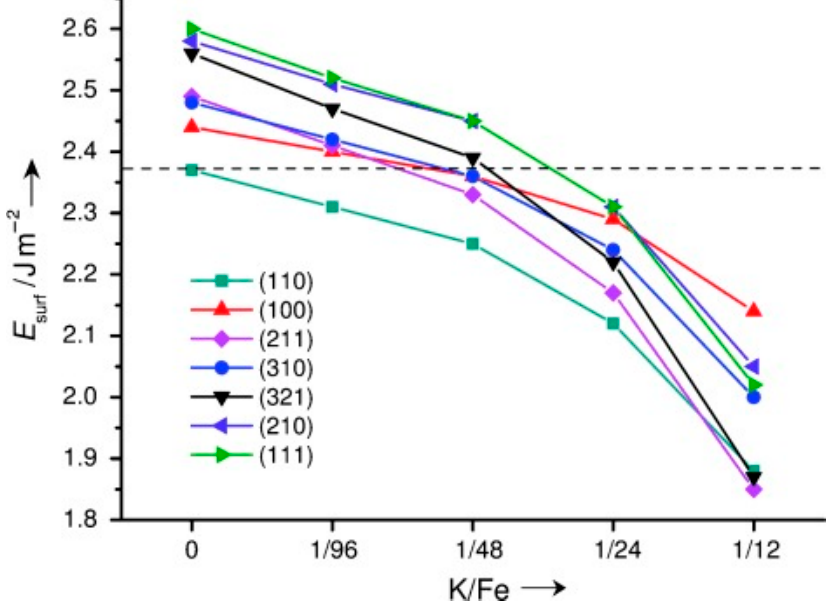
Figure 10. Surface energy variation versus the surface atomic ratio of K to Fe. Reproduced with permission from Reference [182]. Copyright© 2011, John Wiley and Sons.